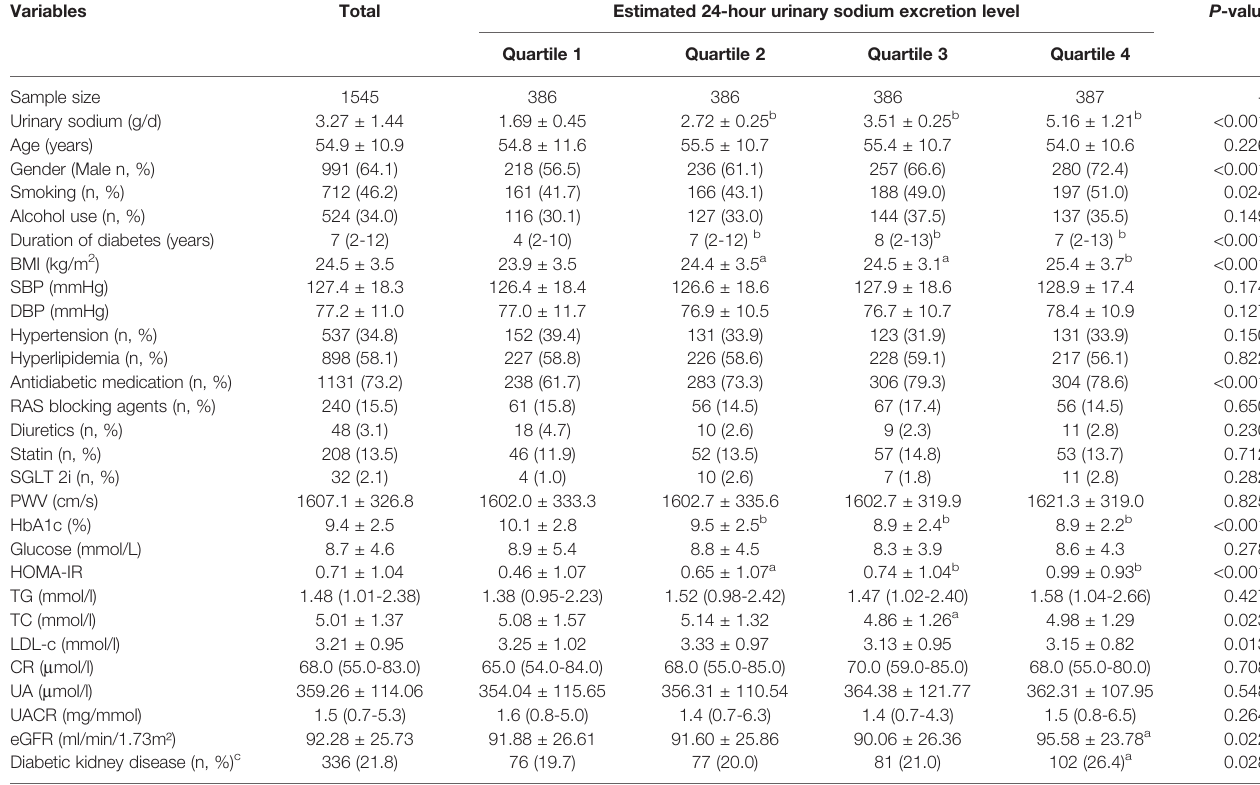
TABLE 2 | Characteristics of patients categorized by quartile of urinary sodium excretion level.